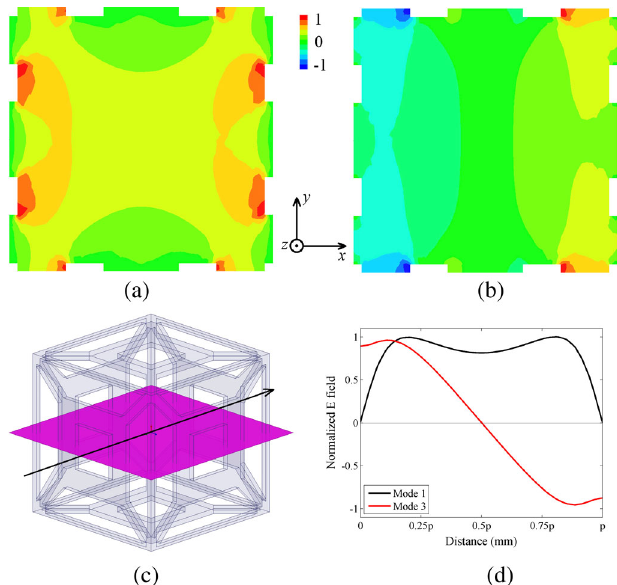
FIG. 3. Field patterns of the longitudinal eigenmodes in the Γ − X region. The cutting plane is the middle plane going through the center of the beam hole. Black arrows denote possible beam paths for the purpose of later sections. Waves propagate to the right. The fields are shown on a linear scale. (a) Mode 1 (the negative index mode); y and z directions are symmetric. (b) Mode 3 (the positive index mode). (c) Cutting plane and future beam position. (d) Axial field patterns at the synchronized points with a relativistic beam at the speed of